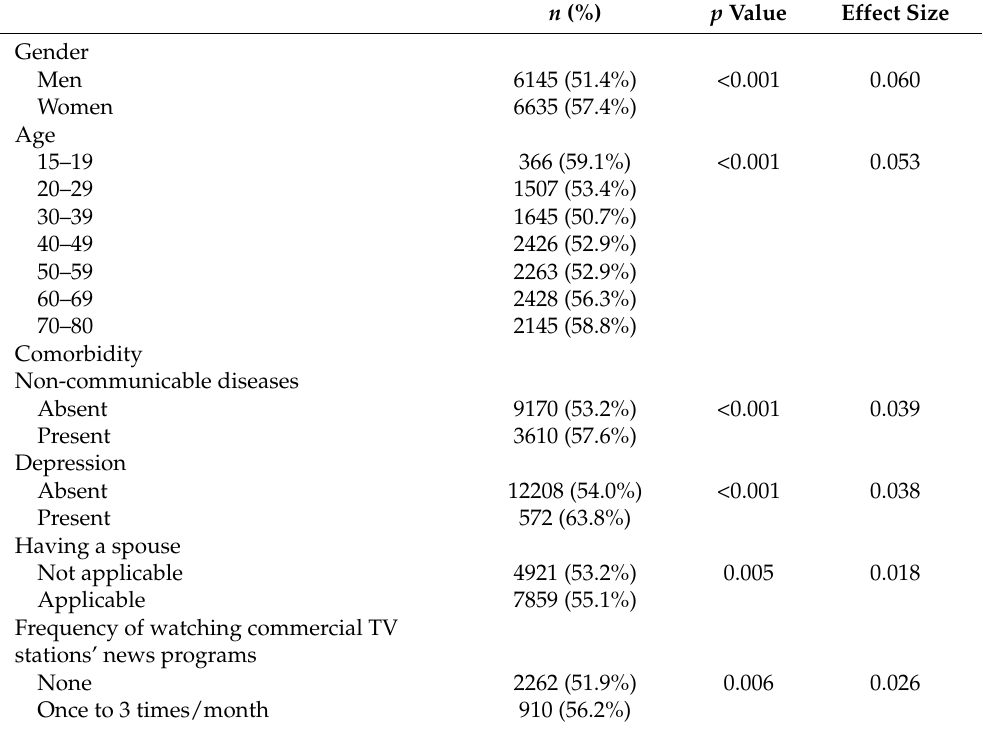
Table 4. Proportions of reporting a median or higher Fear of COVID-19 Scale